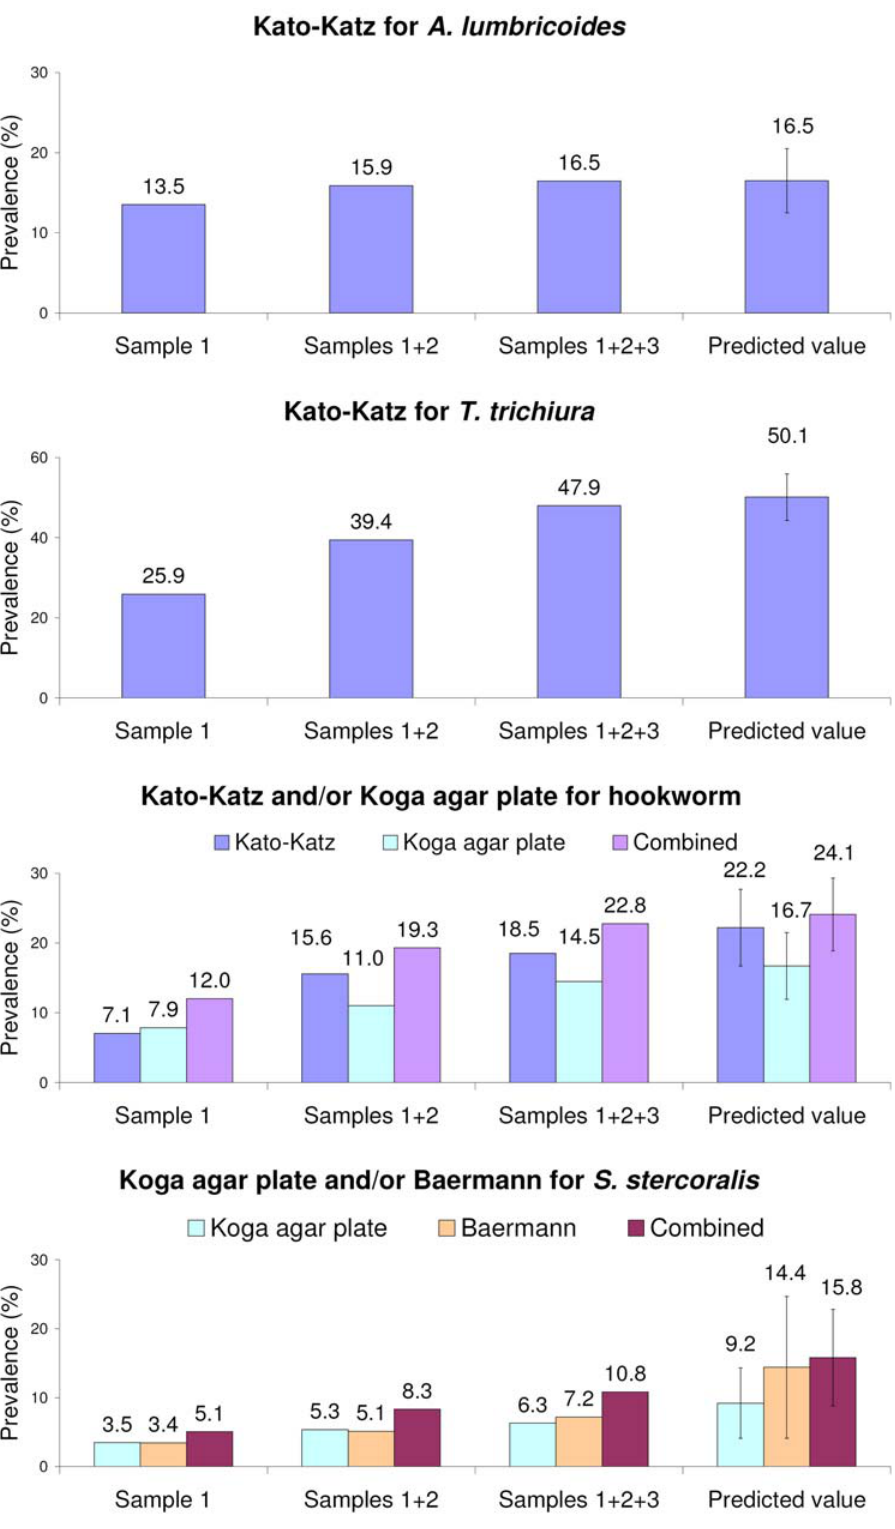
Figure 2. Diagrams detailing the differences in the observed and estimated ‘true’ prevalence of soil-transmitted helminth infections employing different diagnostic methods in relation to the number of stool samples from children from Chaani and Kinyasini schools, Zanzibar.